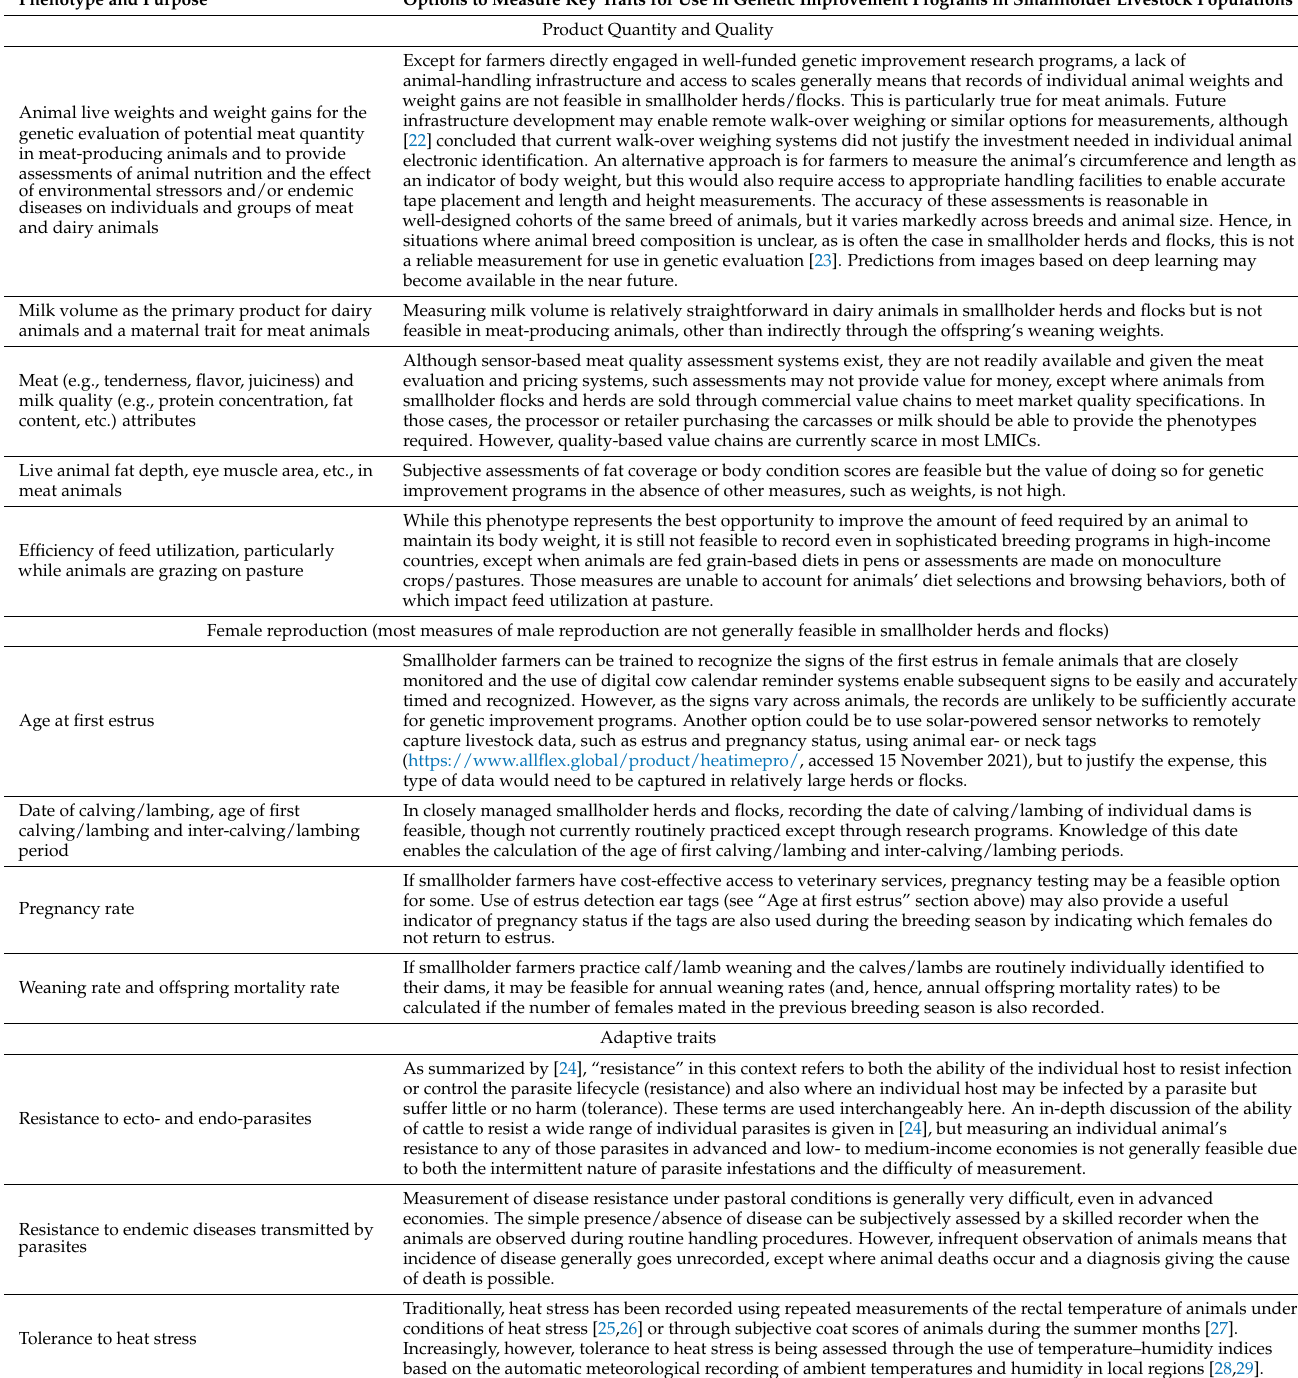
Table 1. Phenotypes that should ideally be included in livestock-breeding objectives and the feasibility of recording them in smallholder herds and flocks in low- to middle-income